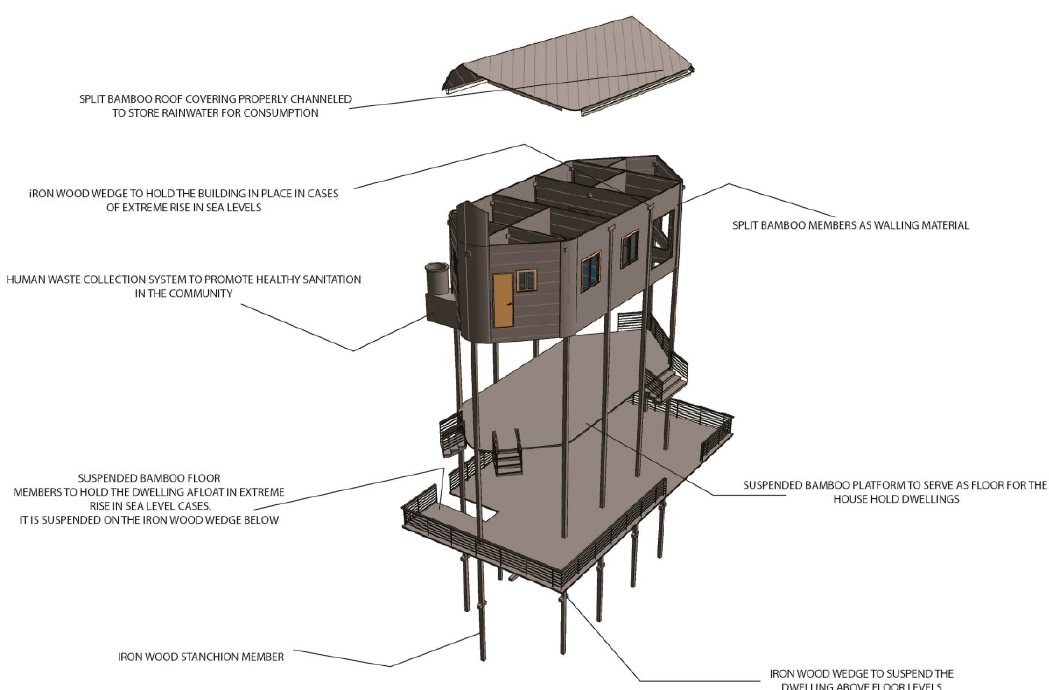
Figure 6. Design of the skeletal analysis of Group B’s proposal for a floating house in Igbokoda. Source: CR4D Charette Team, 2019.